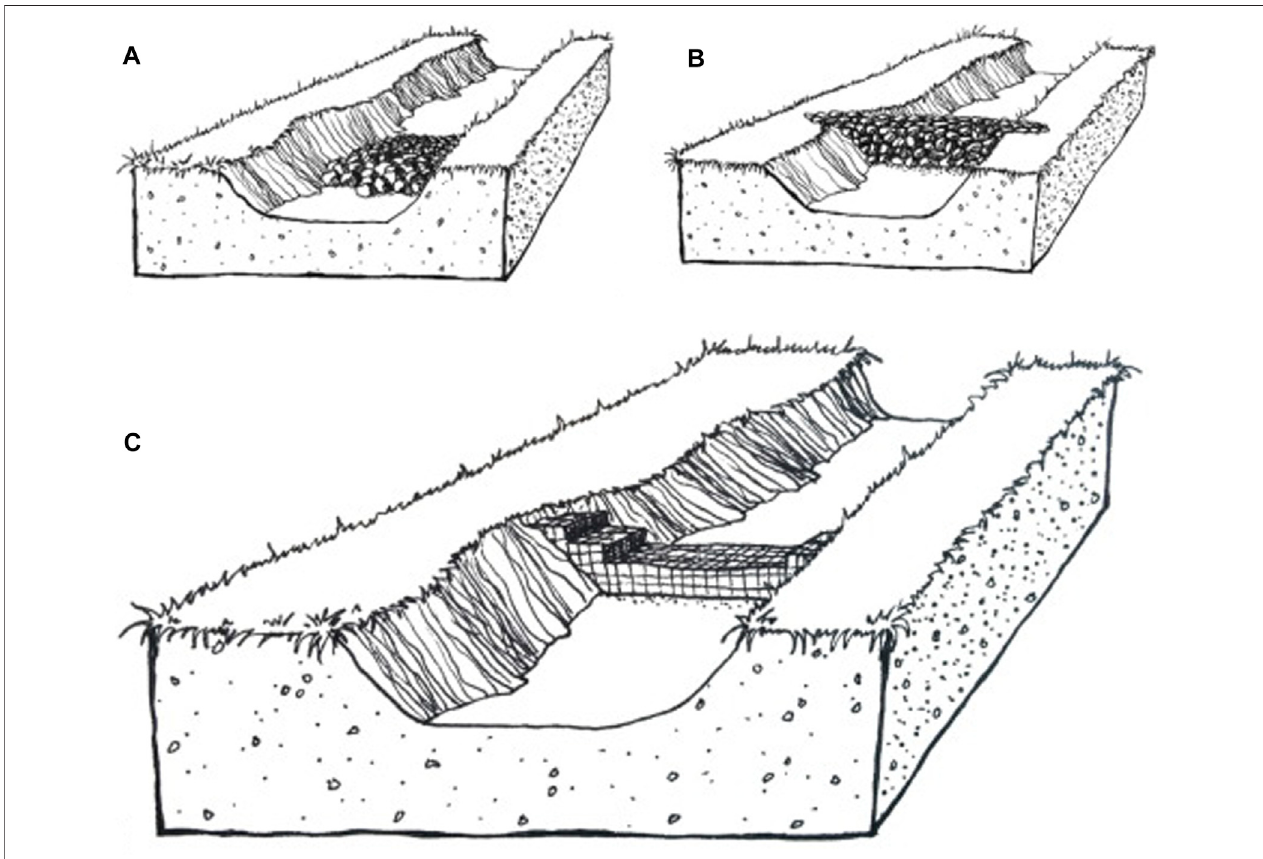
FIGURE 1| Sketchesof rock-detention structures, including: (A) spreader (or one-rock dam), (B) loose-rock check dams (or gully plugs), and (C) larger rock- fi lled wire baskets (gabions) (reprinted from Norman et al., (2017), Figure 1 , Chloé Fandel).